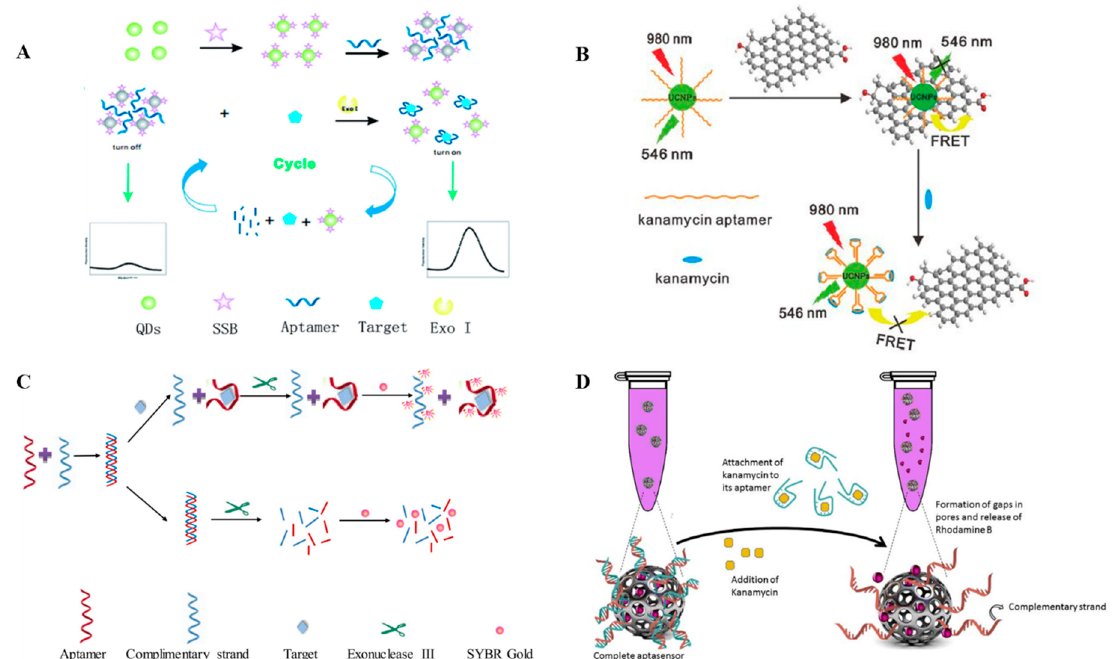
Figure 3. Schematic illustration of a fluorescent aptasensor. ( A ) A fluorescent “on” switch aptasensor containing QDs-SSB [69]. ( B ) Fluorescence resonance energy transfer between kanamycin aptamer UCNPs and graphene [70]. ( C ) Unlabeled fluorescence analysis [71]. ( D ) dsDNA-modified mesoporous silicon nanoparticles (MSNs) loaded with rhodamine B [72].